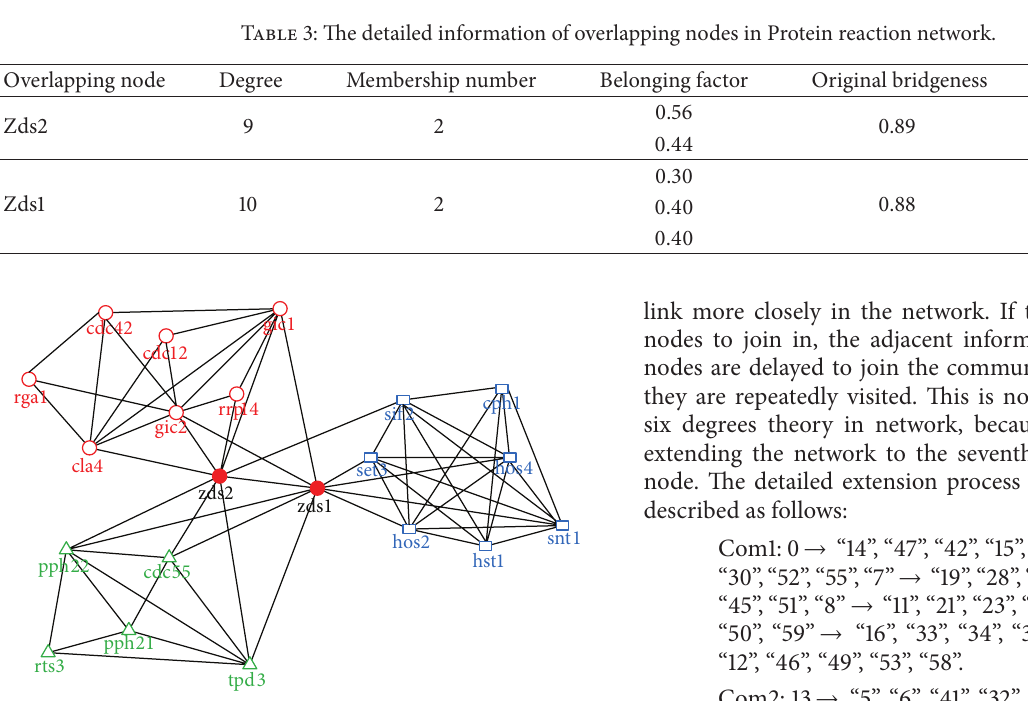
Figure 8: The community structure found by our algorithm in Protein reaction